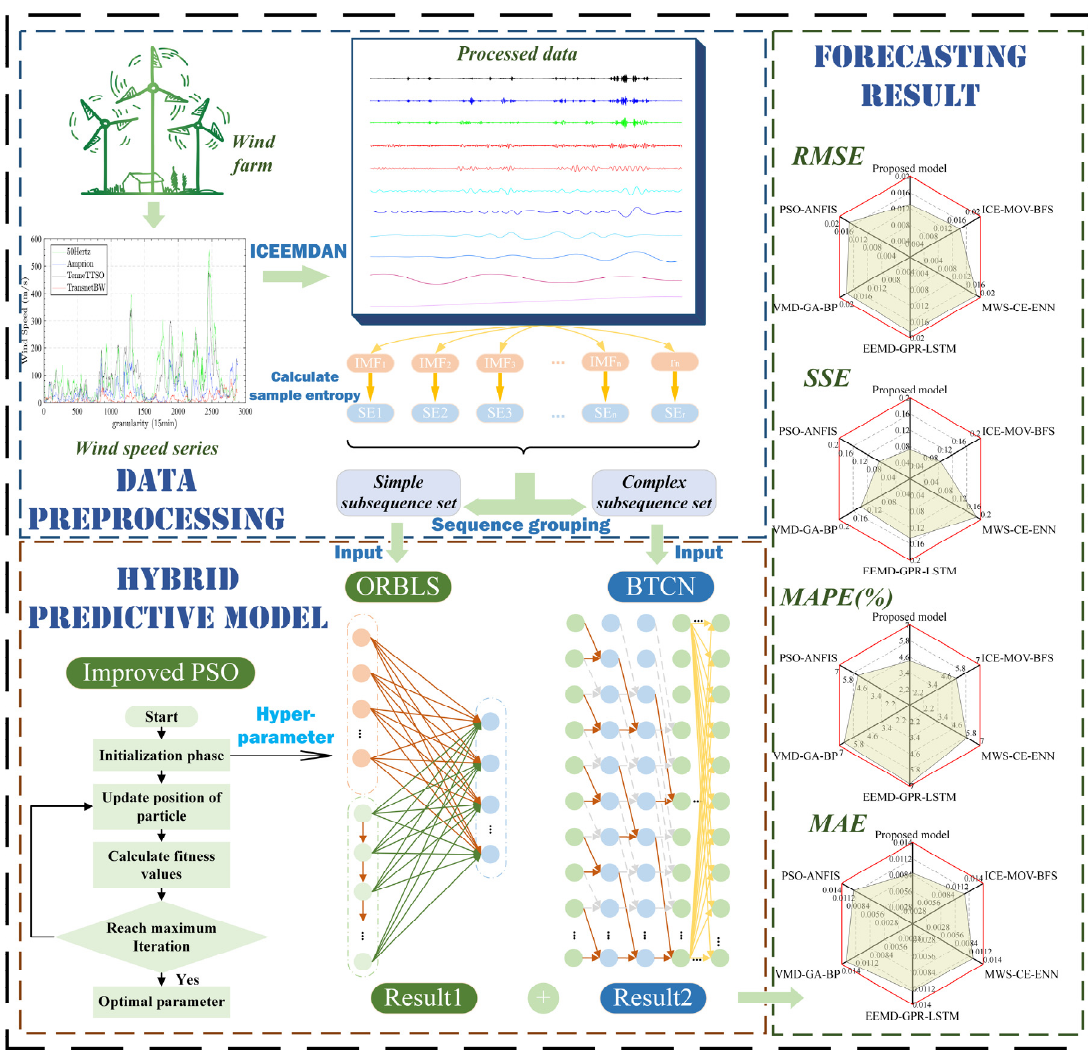
Figure 1. The proposed ultra-short-term wind speed forecasting framework.